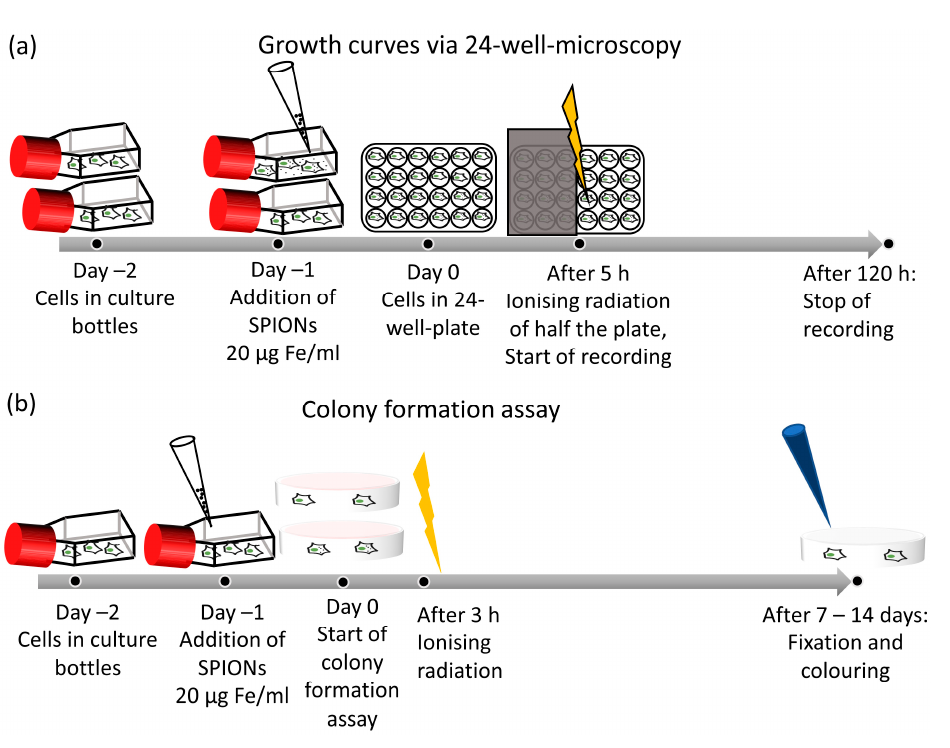
Figure 2. Experimental setup of growth analysis and colony formation assay. ( a ) Timeline of growth curve by 24-well microscopy. ( b ) Timeline of a colony formation assay.